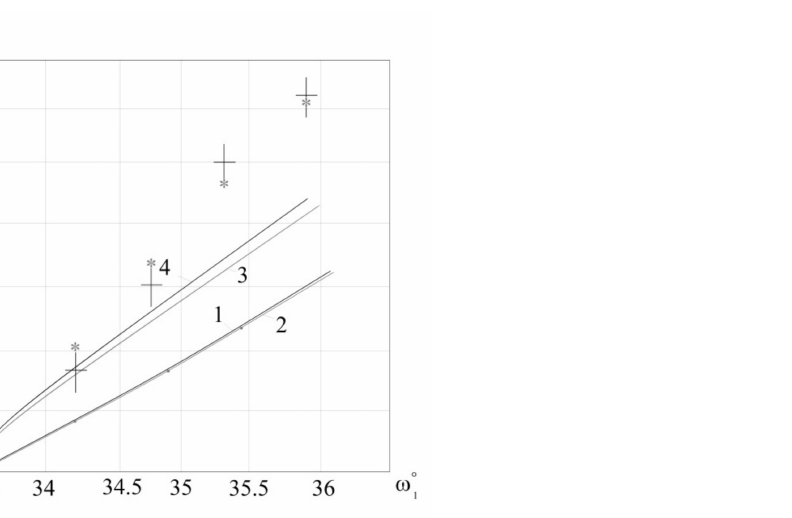
Figure 5. The values of the dimensionless Mach stem height ( y T / | AD | ) at gas flow in the narrowing channel vs. incident shock inclination angle ( ω 1 ). The flow Mach number M = 3.98; large crosses are the experimental data of [12]; curve 1 corresponds to the engineering approach of [43]; circles and approximating curve 2 correspond to the method of [44]; curve 3 are the results of method [28]; curve 4 are data of